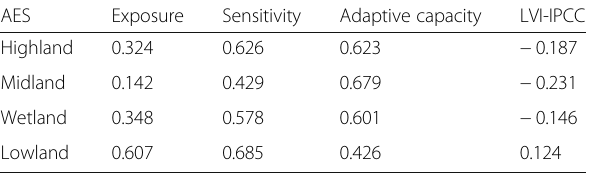
Table 6 Calculated indices for contributing factors and the Livelihood Vulnerability Index under the LVI-IPCC framework